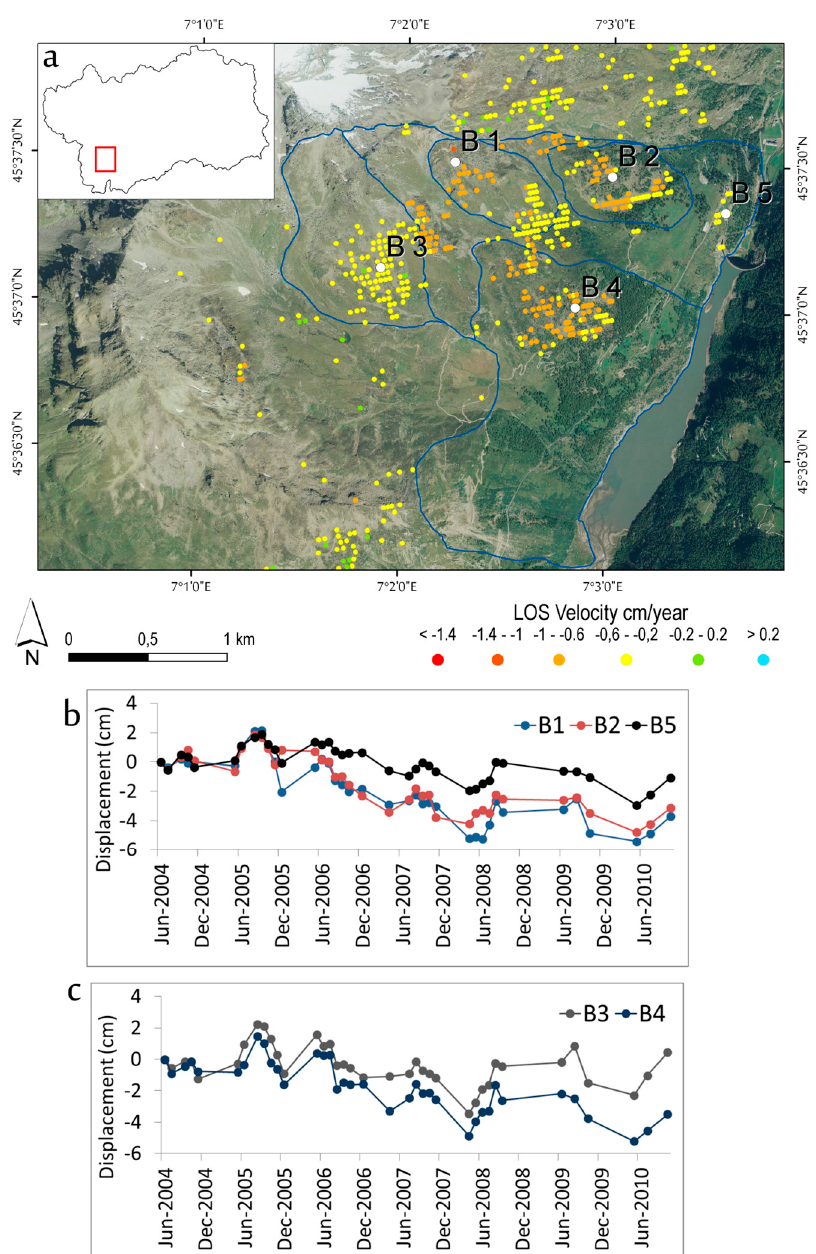
Figure 8. ( a ) Mean deformation velocity map of the Beauregard DsGSD case study, for Envisat ascending dataset. ( b , c ) Time series corresponding to the targets signed by the white dots in the map.